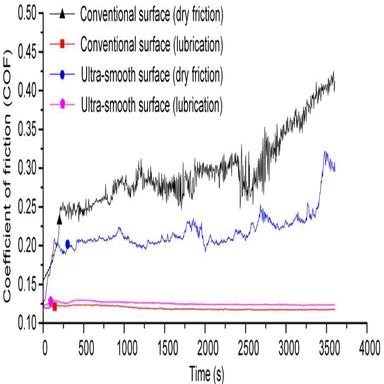
Representative evolution curves of COF with sliding time (distance) under different conditions.